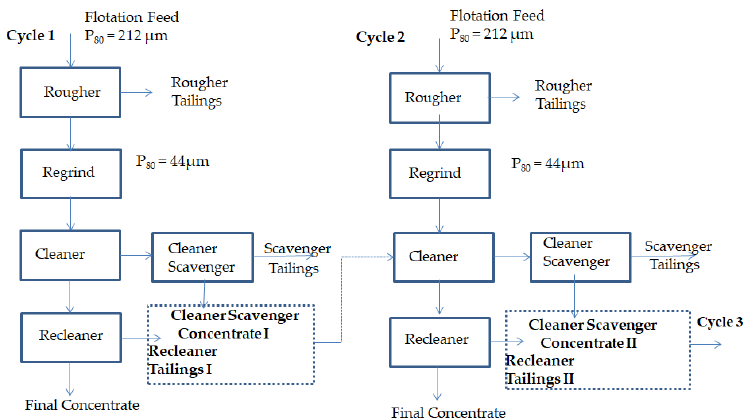
Figure 3. Representation of the locked-cycle